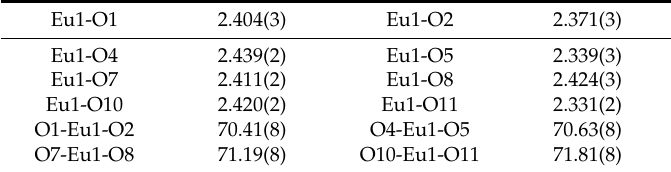
Table 2. Selected bond lengths (Å) and angles ( ◦ ) for the complex 2b .